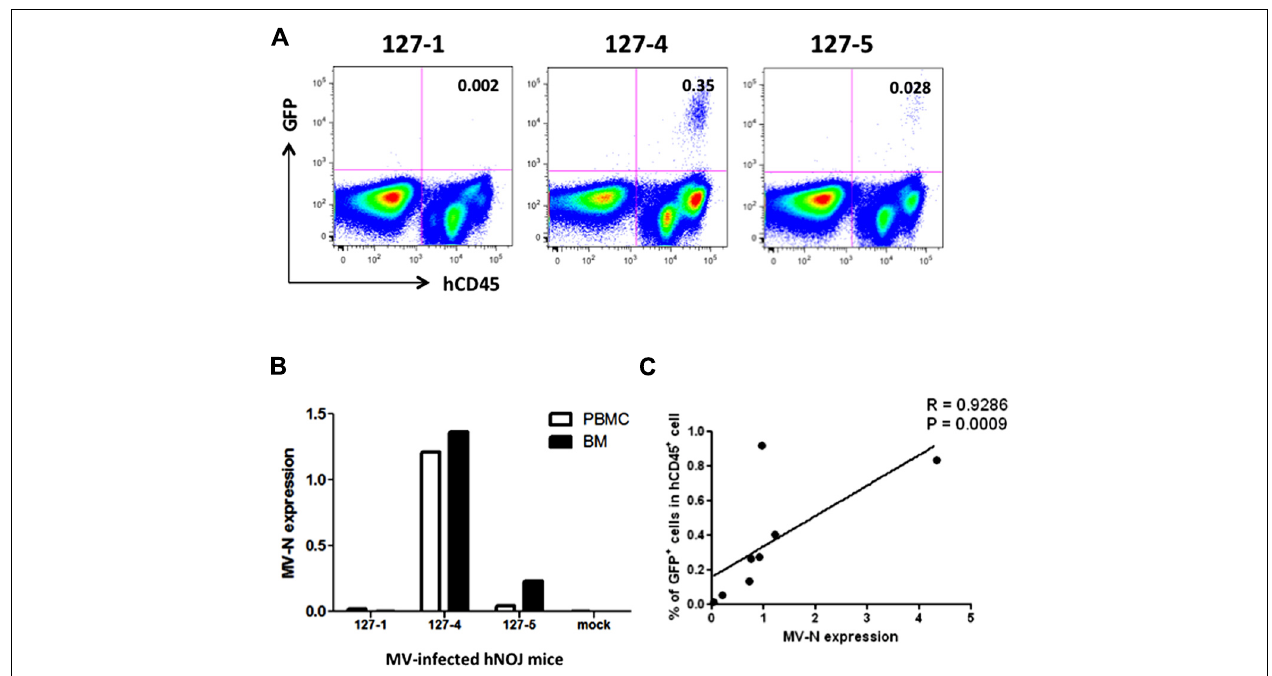
and RNA was prepared. The expression MV-N and RNase P was analyzed as described in the legend for Figure 2B . (C) Correlation between the percentage of GFP + cells among hCD45 + cells in BM and the level of MV-N expression in MV-infected hNOJ mice, at day 7 ( n = 4) or day 10 ( n = 4) p.i. Spearman’s rank correlation coefficient was used for statistical